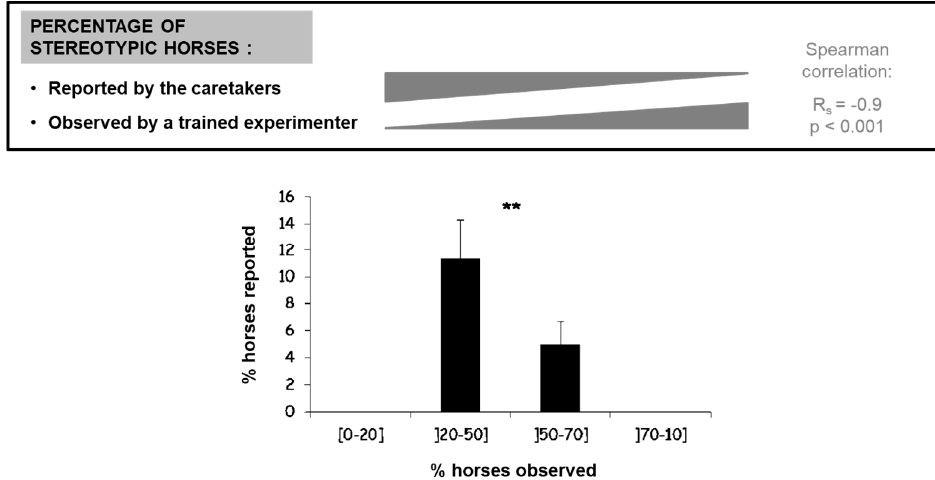
Figure 4. Discrepancy between observed (i.e., direct observation by trained experimenter) and reported (i.e., questionnaires to caretakers) prevalence of stereotypic horses per facility (N = 26 riding schools, 360 horses). Note that there is no report of stereotypic horses in the facilities where most or all horses were observed performing stereotypic behaviors (Spearman correlation). **: Kruskal Wallis test, p = 0.02, Adapted from Lesimple et Hausberger [129].